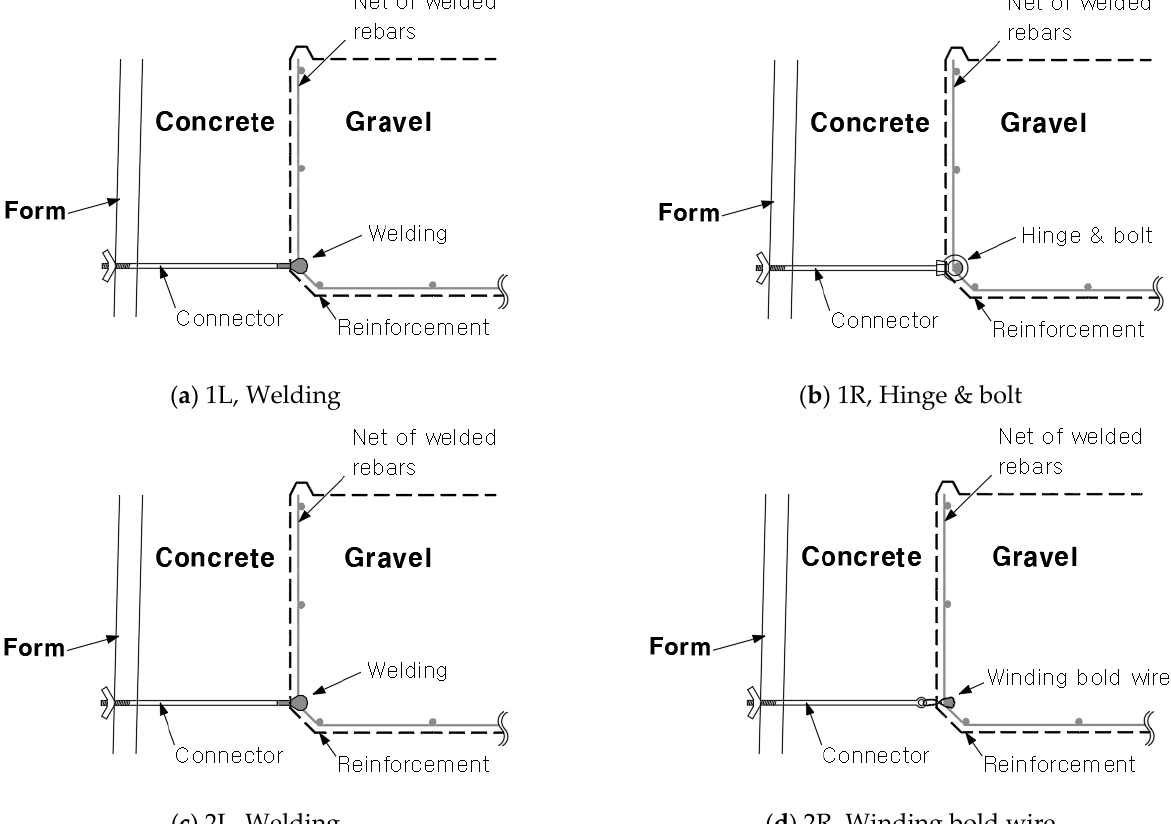
Figure 7. Cross sections of wall- reinforcement connection methods.